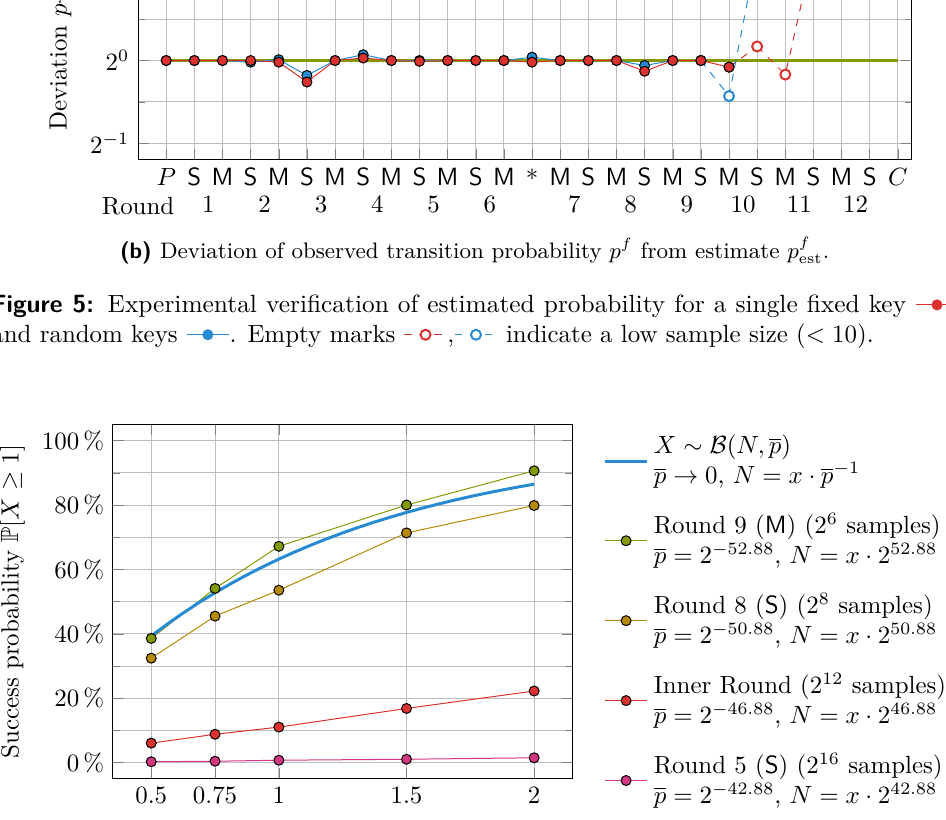
Figure 6: Experimentally observed success probability P [ X ≥ 1] of at least one valid pair within a run of N pairs, where X is the number of valid pairs up to some round in a run. The number of pairs N ≈ x · p − 1 is chosen such that x = E [ X ] ∈ { 0 . 5 , 0 . 75 , 1 , 1 . 5 , 2 } , based on an estimated probability p of a pair to be